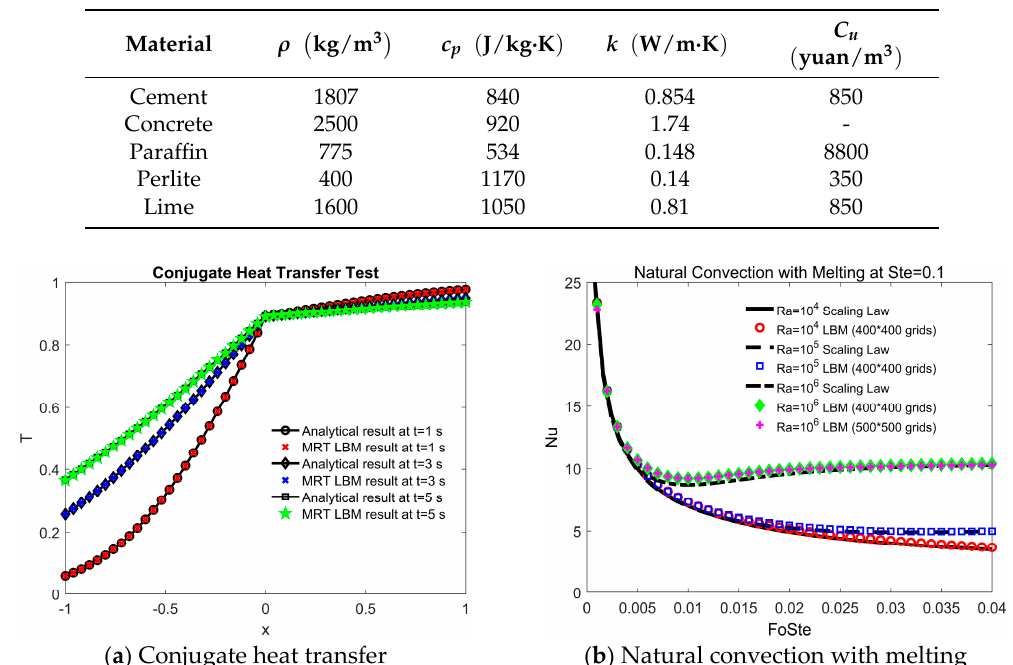
Figure 1. CUDA code calibration for conjugate heat transfer and solid-liquid phase change.